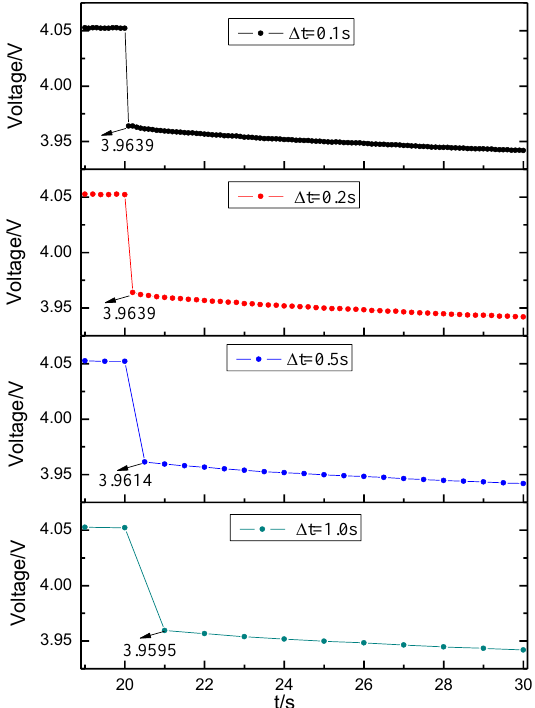
Figure 5. Sample points for different time intervals.